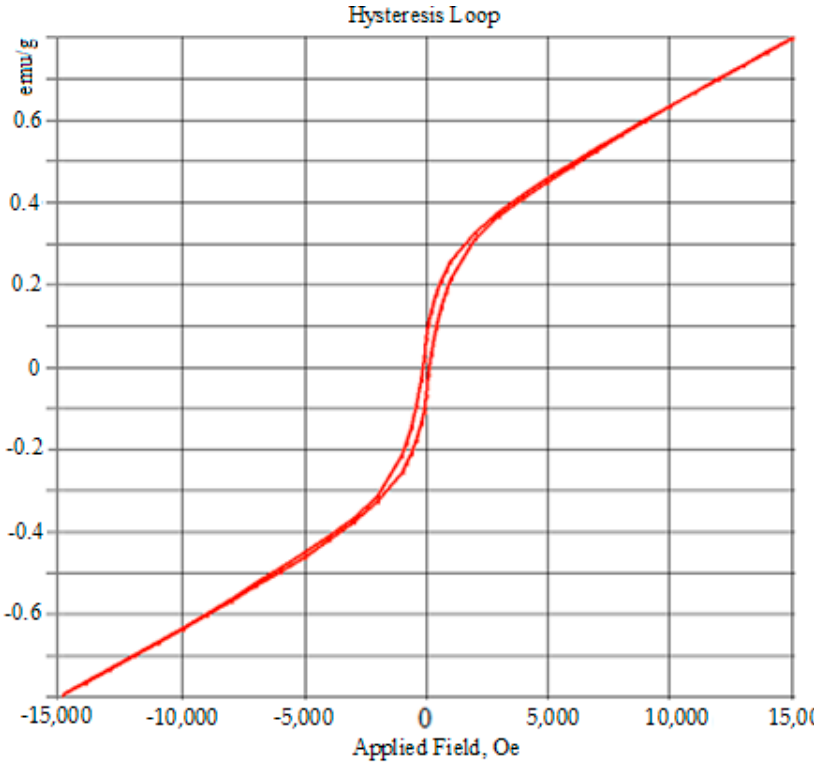
Figure 7. Field dependence of the magnetization of the NdFeO 3 nanoparticles annealed at 750 °C for 1 h.